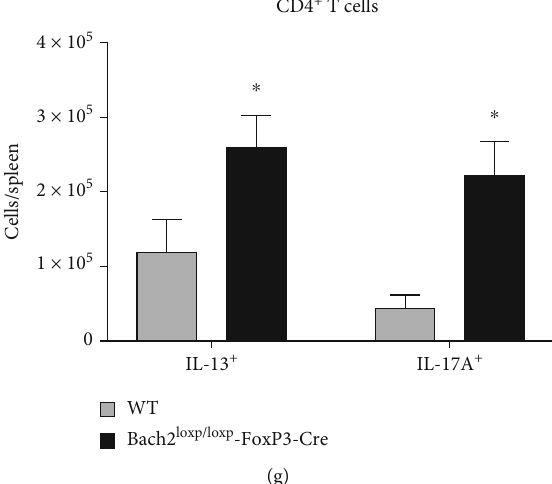
Figure 1: Bach2 regulates classical and regulatory T cell homeostasis. Splenocytes from naïve WT and Bach2 loxp/loxp FoxP3-Cre mice were stained for intracellular and extracellular antigens and analyzed by fl ow cytometry. (a) Frequency and (b) number of Foxp3 +ve Treg cells. (c) Histograms are gated on Foxp3 +ve Treg cells and show staining for the indicated markers in WT (shaded) and Bach2 loxp/loxp FoxP3-Cre mice (line) mice. (d) Frequency and numbers of Tregs expressing the indicated molecules. (e) Activation of classical T cells was analyzed by staining with anti-CD44 and anti-CD62L; contour plots are gated on CD4 or CD8 T cells. (f), (g) Splenocytes were stimulated for 5hrs in vitro with PMA and ionomycin in the presence of Brefeldin A, and cytokine production by CD4 and CD8 T cells was measured by intracellular staining for (f) IFN- γ and (g) IL-13 and IL-17A. This experiment was repeated three times with similar results, 4-5 mice per group. ∗ p < 0 : 05